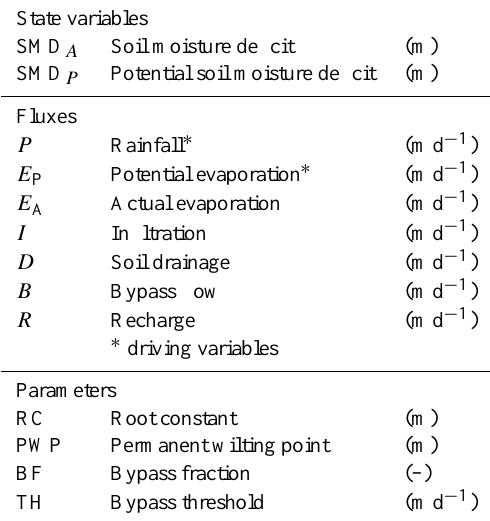
Table 3. Simple model states, fluxes and